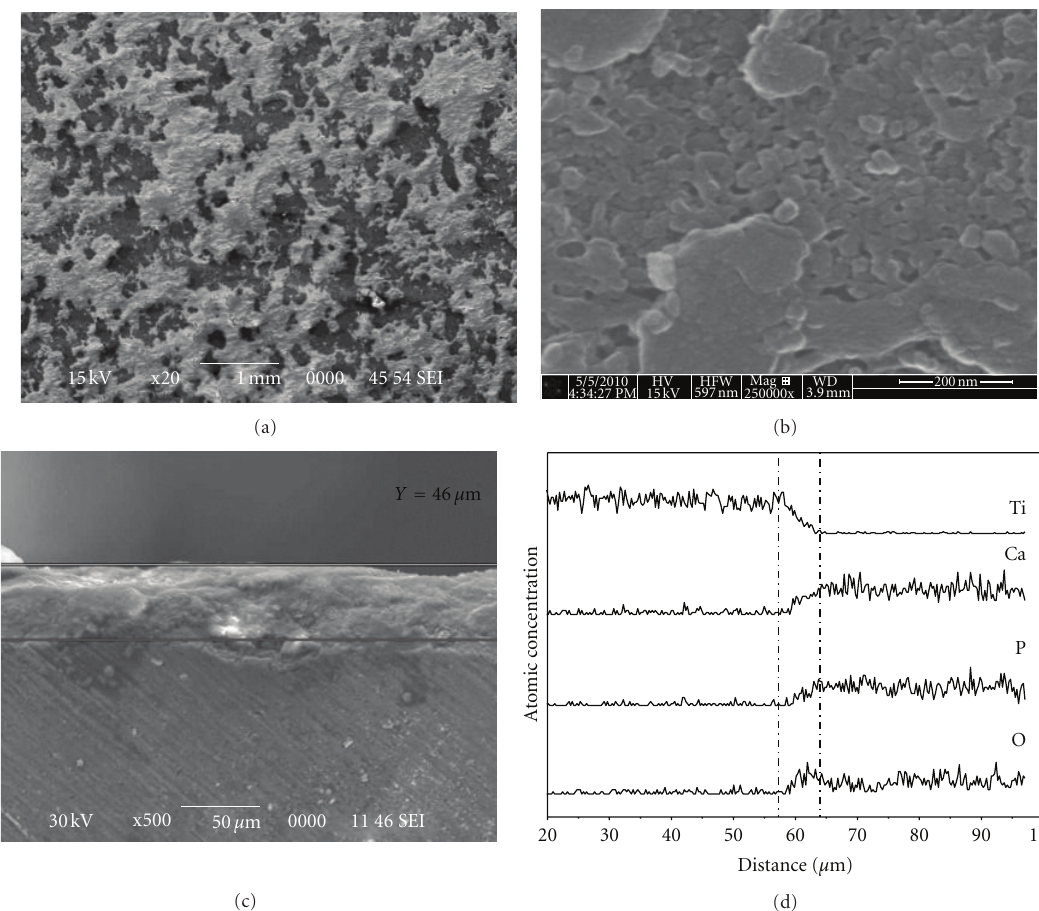
Figure 6: (a) and (b) Surface morphologies of the as-synthesized HA coating after one hour of milling (c) cross-section microstructure and (d) concentration profile of as-synthesized HA coating. Table 2: Fe and Cr contamination in one-hour milled HA powder.